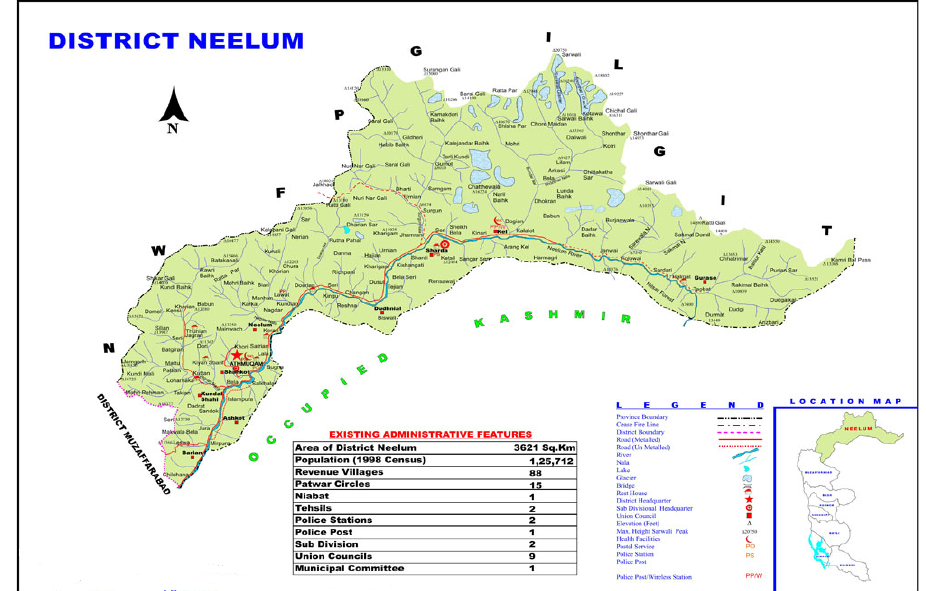
Figure 1. Geographical map showing the geolocation of the district of Neelam, AJK,